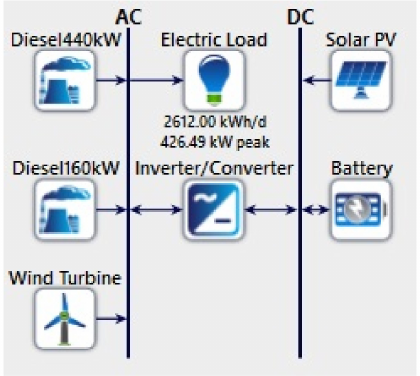
Figure 8. Schematic diagram of the off-grid hybrid system.